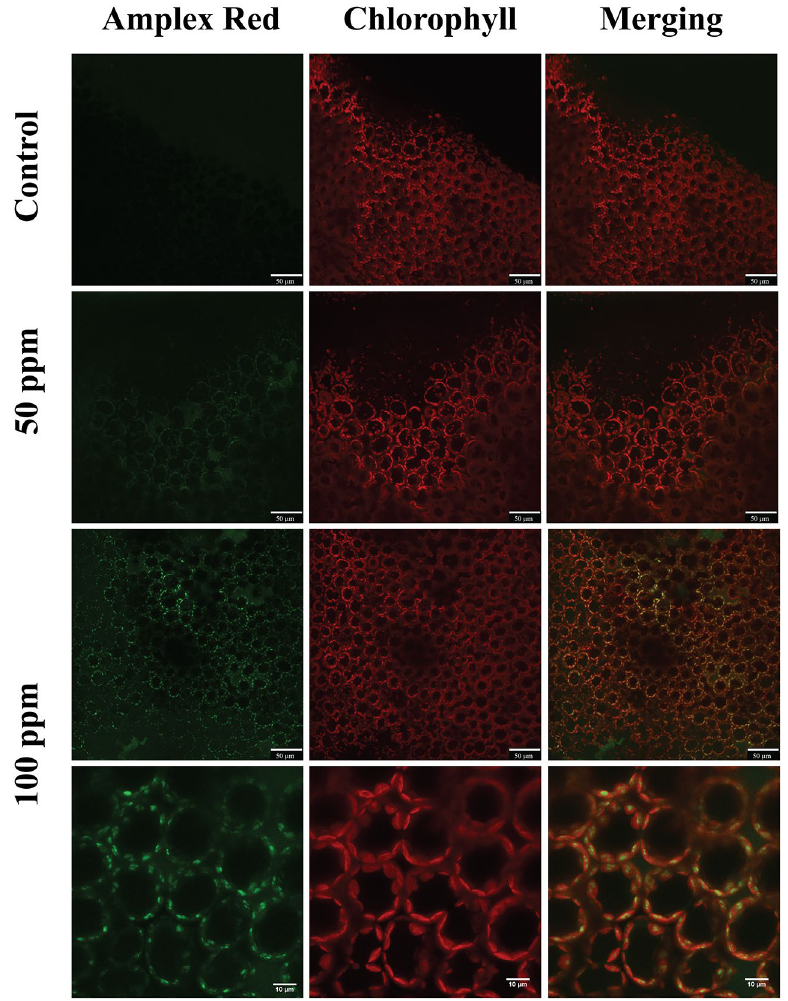
Figure 6. False-colour image analysis reconstructions from confocal laser-scanning microscope observations and fluochemical localization of H 2 O 2 in an image analysis. The production of H 2 O 2 is shown by the green fluorescence. The chloroplasts are shown by a bright red colour caused by chlorophyll fluorescence. Brassica nigra leaves were incubated for 20 min with MES buffer + 0.1% Tween 20 as control, and 50 ppm or 100 ppm of ( Z )-11-16:Ald (diluted in MES buffer + 0.1% Tween 20). Scale bars are indicated on pictures. Exposure to ( Z )- 11-16:Ald at 100 ppm leads to accumulation of H 2 O 2 in cells. n = 2 for each